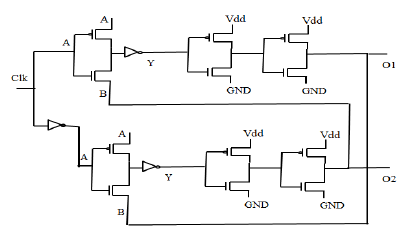
Figure 9. Non-overlapping clock generator circuit design using FINFET